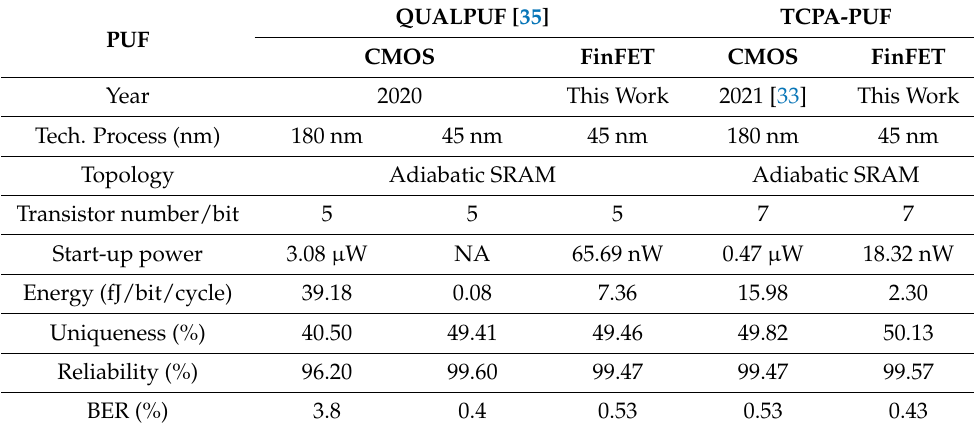
Table 2. Comparison of conventional and proposed adiabatic PUFs (with T = 27 ◦ C and C L = 10 fF, f Cb = 10 MHz, and f Vpc = 100